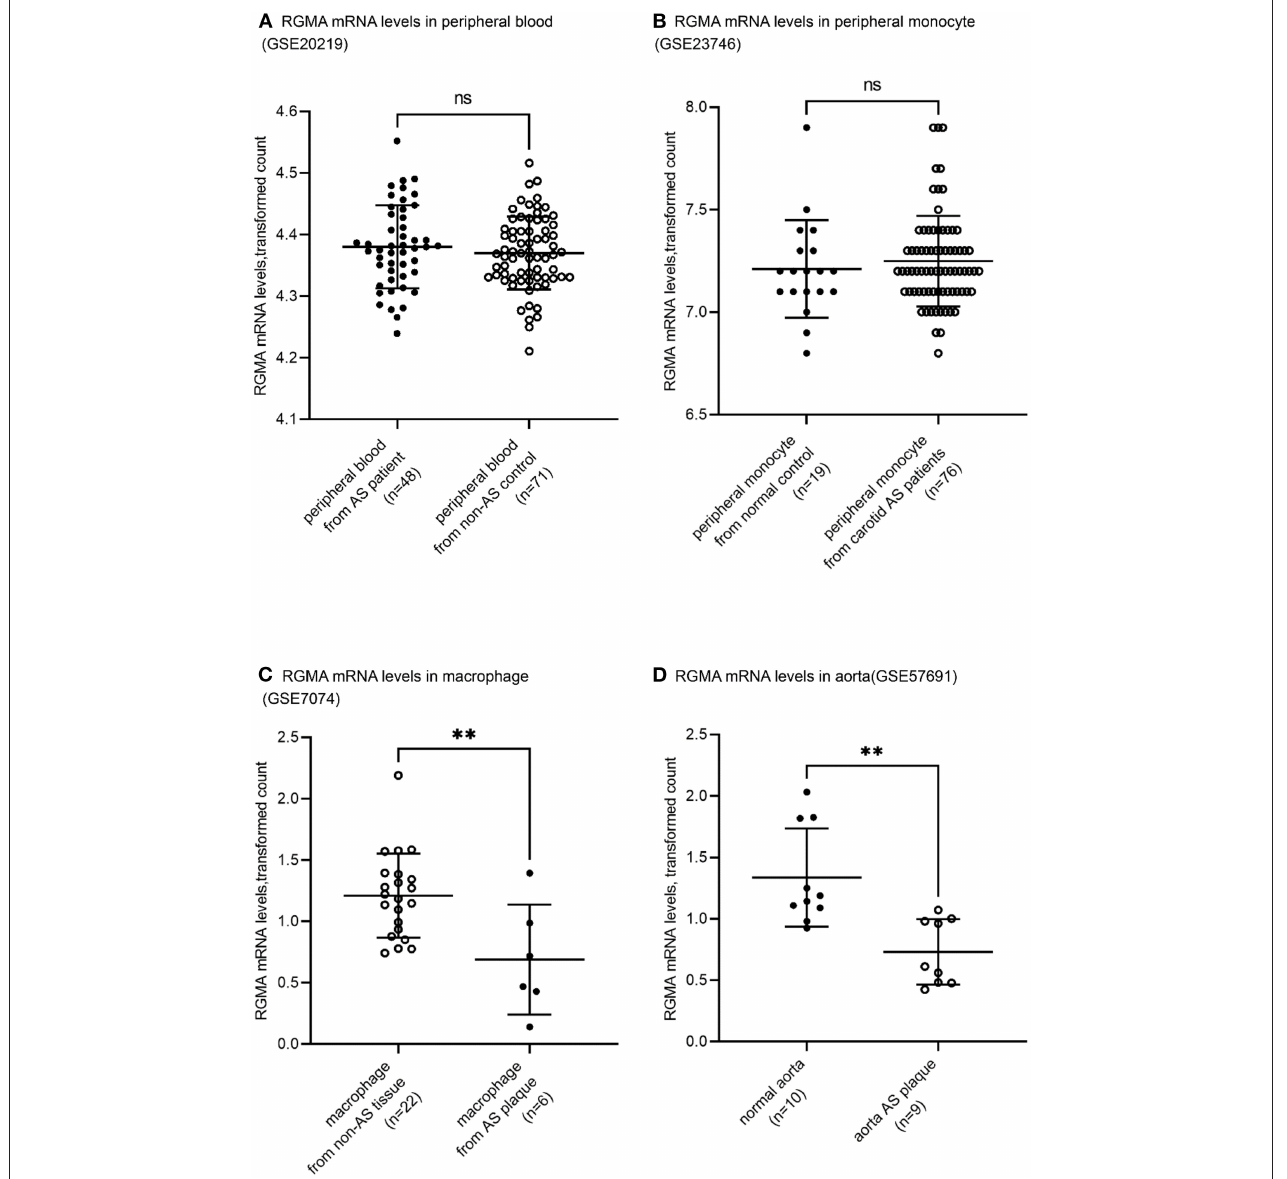
FIGURE 1 | Tissue-specific RGMA expression pattern related to human atherosclerosis development. (A,B) The RGMA mRNA transcription level in peripheral blood and peripheral monocyte showed no significant discrepancy between AS-related patients and normal control. All data were derived from independent cohorts in GEO database (GSE20129, GSE23746). (C,D) The RGMA mRNA transcription levels in atheroma plaque and macrophages isolated from plaque were significantly higher than those in the normal artery and macrophage from non-AS tissue. All data were derived from independent cohorts in GEO database (GSE7074, GSE57691). There were 254 genes presenting the equal or higher differential expression magnitude than RGMa’s in GSE7074. There were 2,122 genes presenting the equal or higher differential expression magnitude than RGMa’s in GSE57691. The central horizontal lines indicate mean, and the upper and lower whisker marks indicate SD. ns, not significant; ** p <